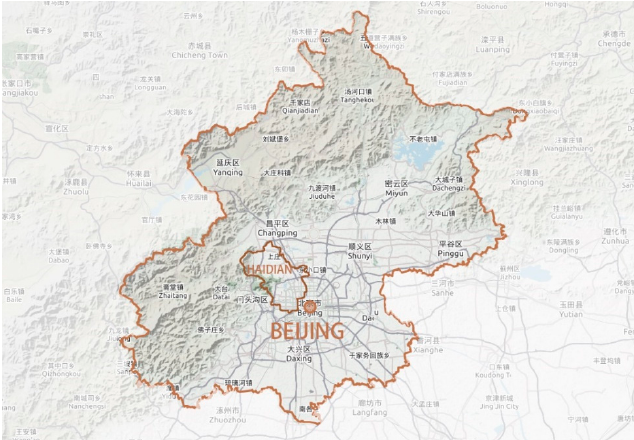
Figure 1. Map showing the location of Haidian District.